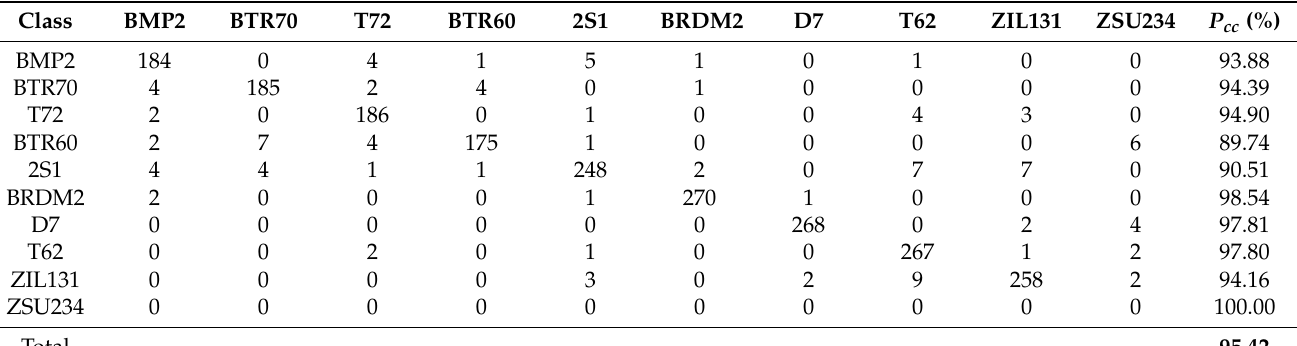
Table 5. Confusion matrix of the recognition result from the DS-AE network related to Table